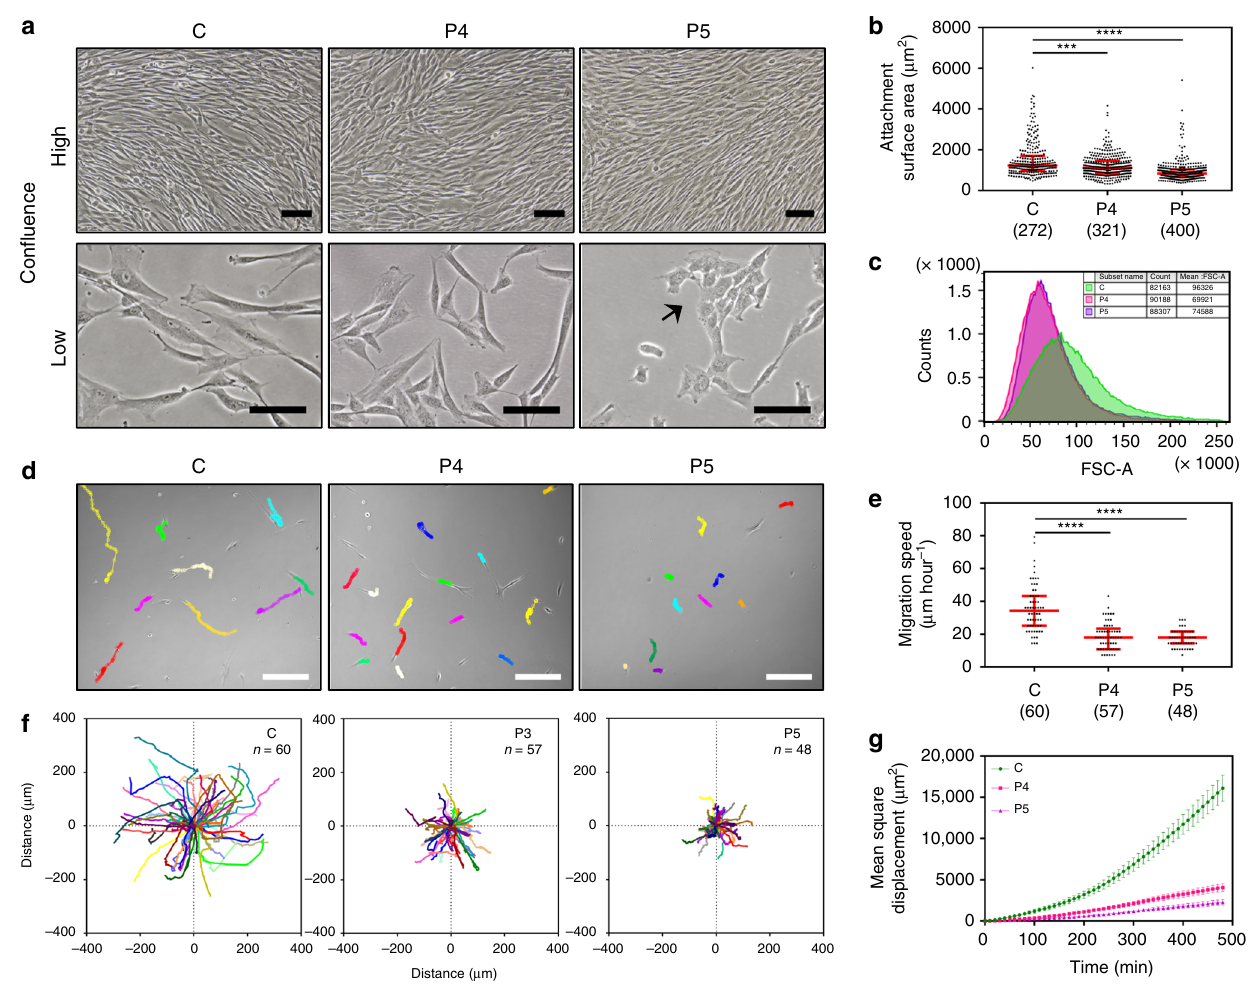
Fig. 3 Reduced cell attachment surface area, volume and migratory capacity of ACTB -AST fi broblasts. a Micrographs of control (C), patient 4 (P4, p. Ala331Valfs*27) and patient 5 (P5, p.Ser338_Ile341del) primary dermal fi broblasts at high (top row) and low (bottom row) con fl uence. At low con fl uence, ACTB -AST cells are distinctly smaller than controls and P5 cells grow in aggregates (arrow). All scale bars are 100 µ m; b Quanti fi cation of the cell attachment surface area from immuno fl uorescence analyses (i.e. Figure 4e) shows reduced coverage distribution by ACTB -AST cells (median and IQR, the number of cells analyzed in 4 experiments is given in brackets); c Flow cytometry analysis of the Forward Scatter Area (FSC-A) vs. normalized cell count (100,000 events from 1 experiment) shows a reduction in ACTB -AST cell volume (P4: pink, P5: purple) compared to the control (green); d – g Migration assays demonstrate reduced migratory capacity for ACTB -AST patient primary fi broblasts; d Representative images at 8 h with migratory tracks overlaid. Scale bars are 100 µ m; e Migration speed of individual cells represented in µ m per hour (median and IQR); f Trajectories of all tracks recorded for C, P4 and P5 from 0 h (origin) to 8 h (5 movies from 2 technical replicates, n = number of cells analyzed); g Mean square displacement analysis of C (green), P4 (magenta) and P5 (purple) fi broblasts (mean ± s.e.m.). Signi fi cance was determined with the Kruskal – Wallis test, where *** p < 0.001 and **** p <